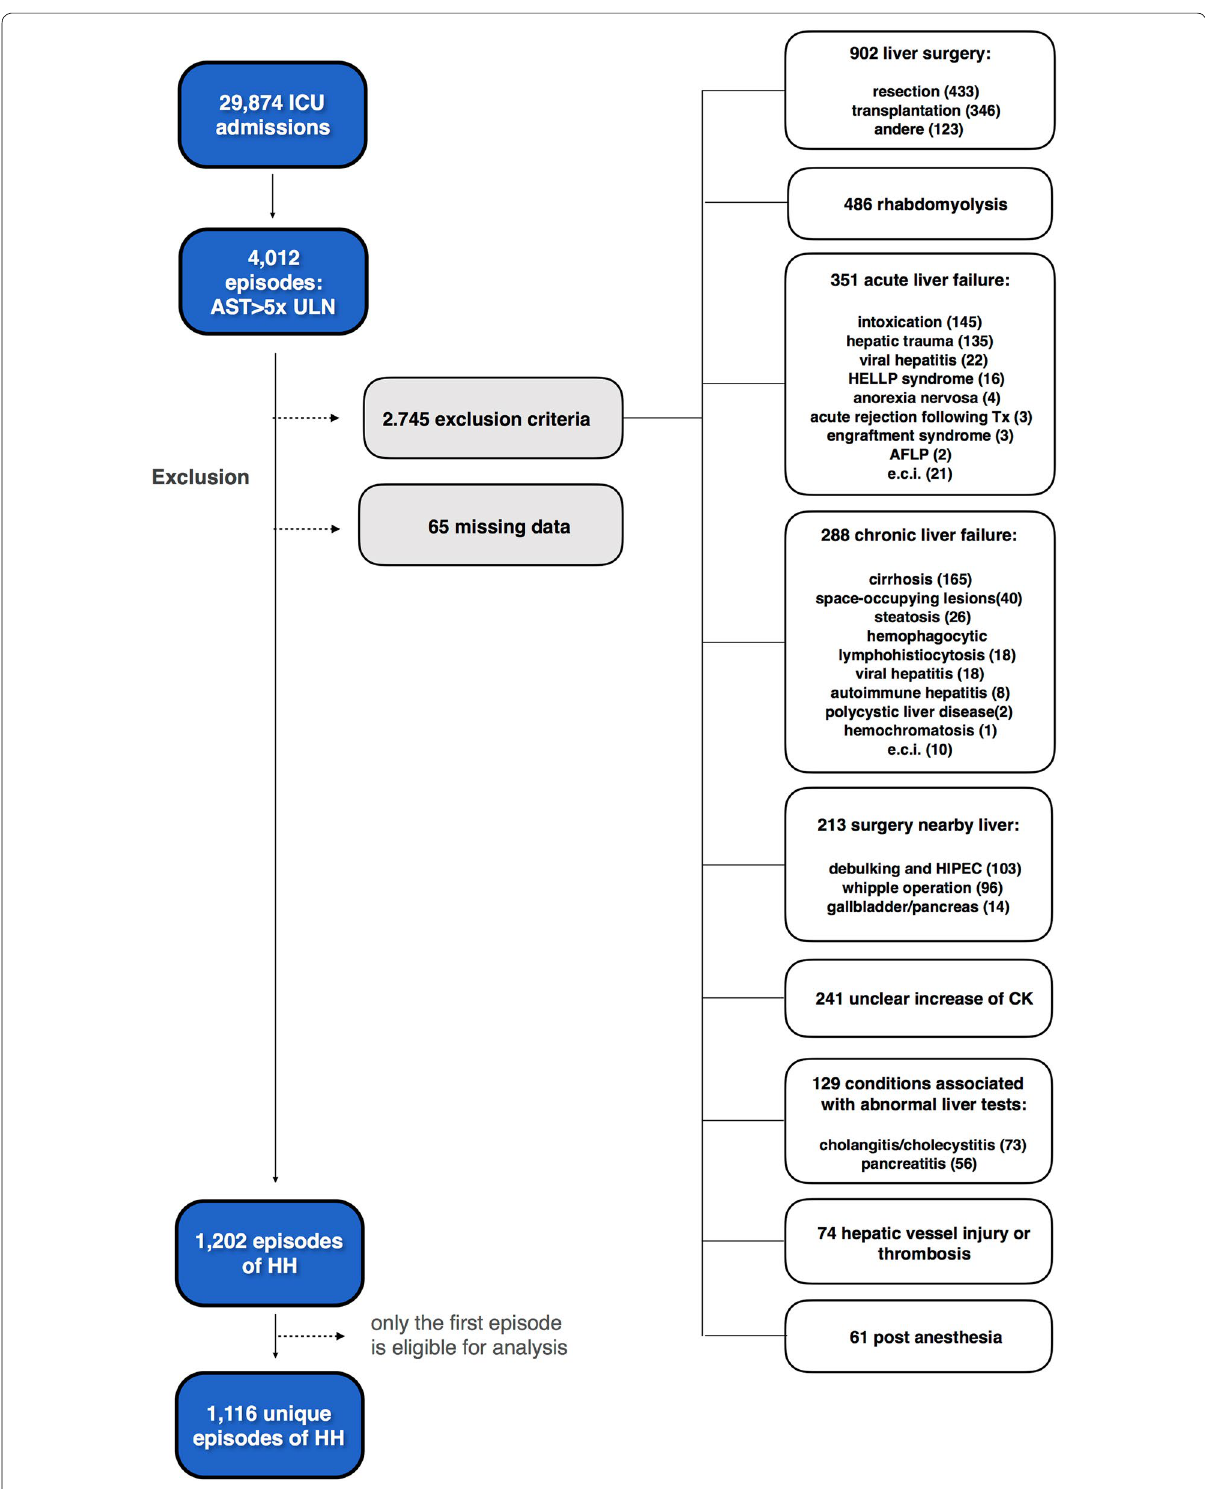
Fig. 1 Flow diagram of the exclusion criteria. AFLP acute fatty liver of pregnancy, AST aspartate aminotransferase, CK creatine kinase, e.c.i e causa ignota, HELLP hemolysis, elevated liver enzymes and low platelet count, HH hypoxic hepatitis, HIPEC hyperthermic intraperitioneal chemotherapy, ICU intensive care